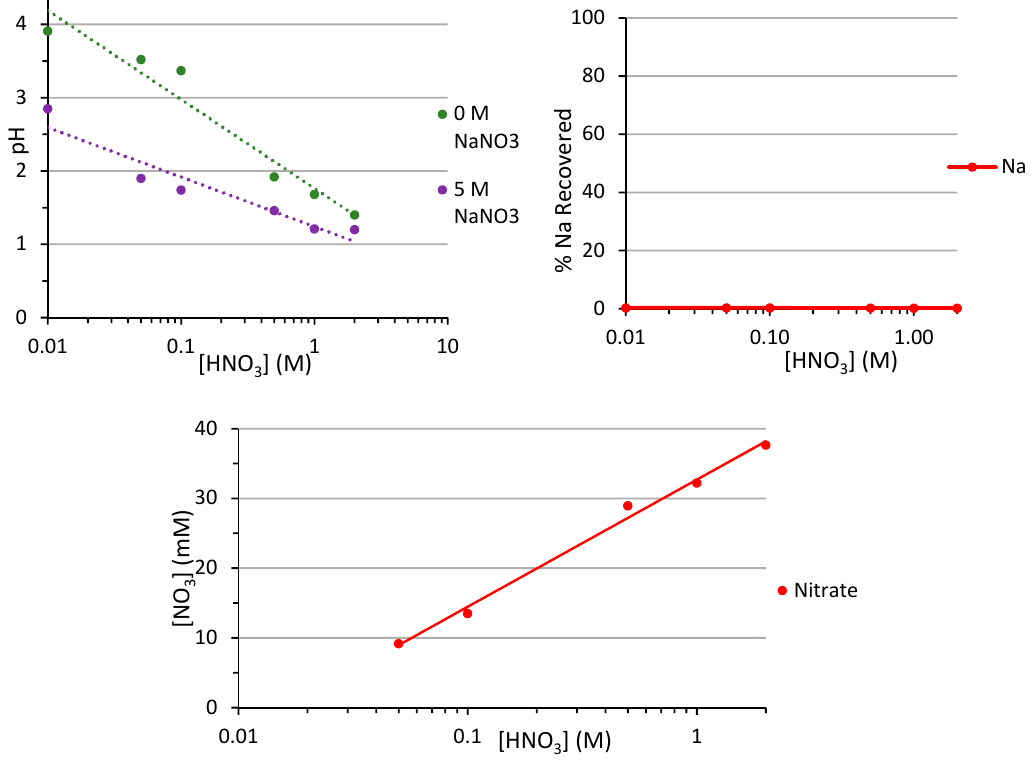
Figure 5. ( Top left ): The pH of aqueous solutions following contact of IL (0.1 M) in toluene loaded with HNO 3 (0.01–2.00 M) from NaNO 3 (0 and 5 M); ( top right ): The extraction of Na with IL (0.1 M) from 5 M NaNO 3 and HNO 3 (0.01–2.00 M) solution; ( bottom ): Determination of the concentration of NO 3- extracted by IL using ion-chromatography. Interpolation used to aid the eye only.